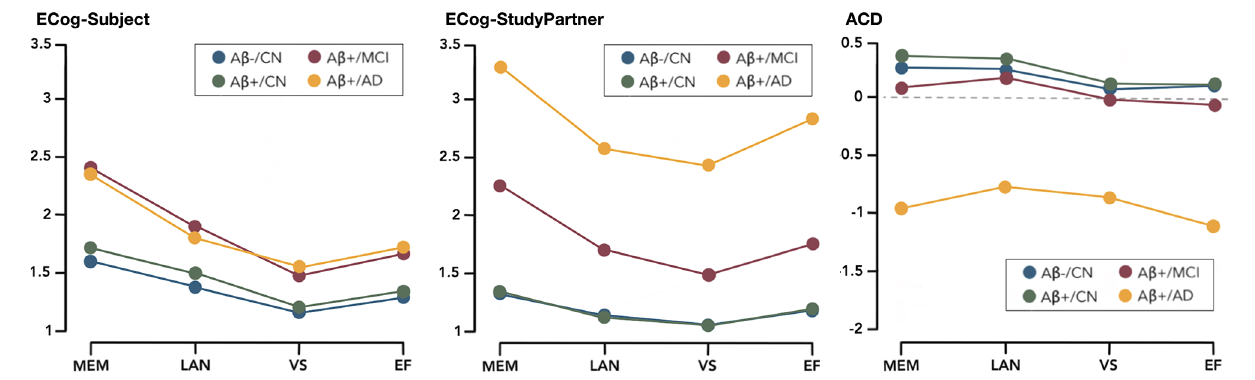
The worst performances were in the discrimination between the two CN groups (all AUCs = 0.70), and between MCI and AD (all AUCs between 0.60 and